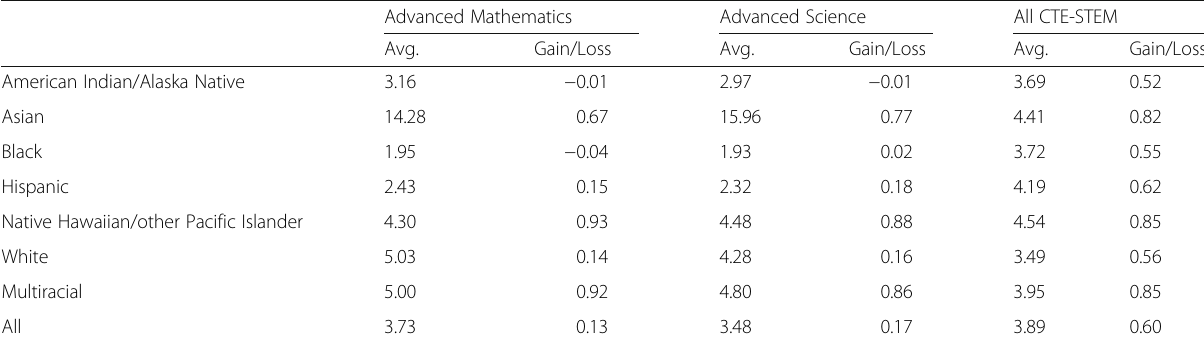
Table 12 Six-year average enrollment rates and gain/loss of enrollment by race/ethnicity in advanced mathematics, advanced science, and CTE-STEM